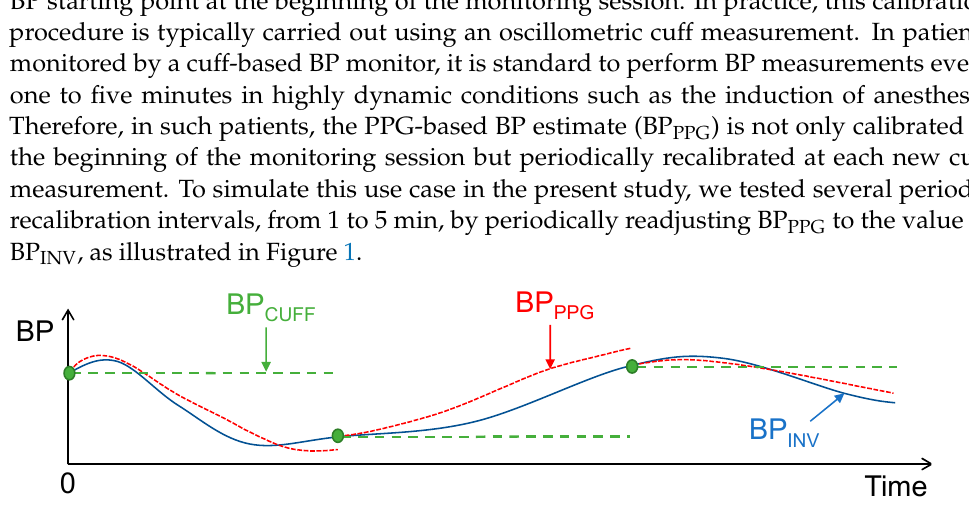
Figure 1. Calibration and simulation of error using an intermittent measurement device.